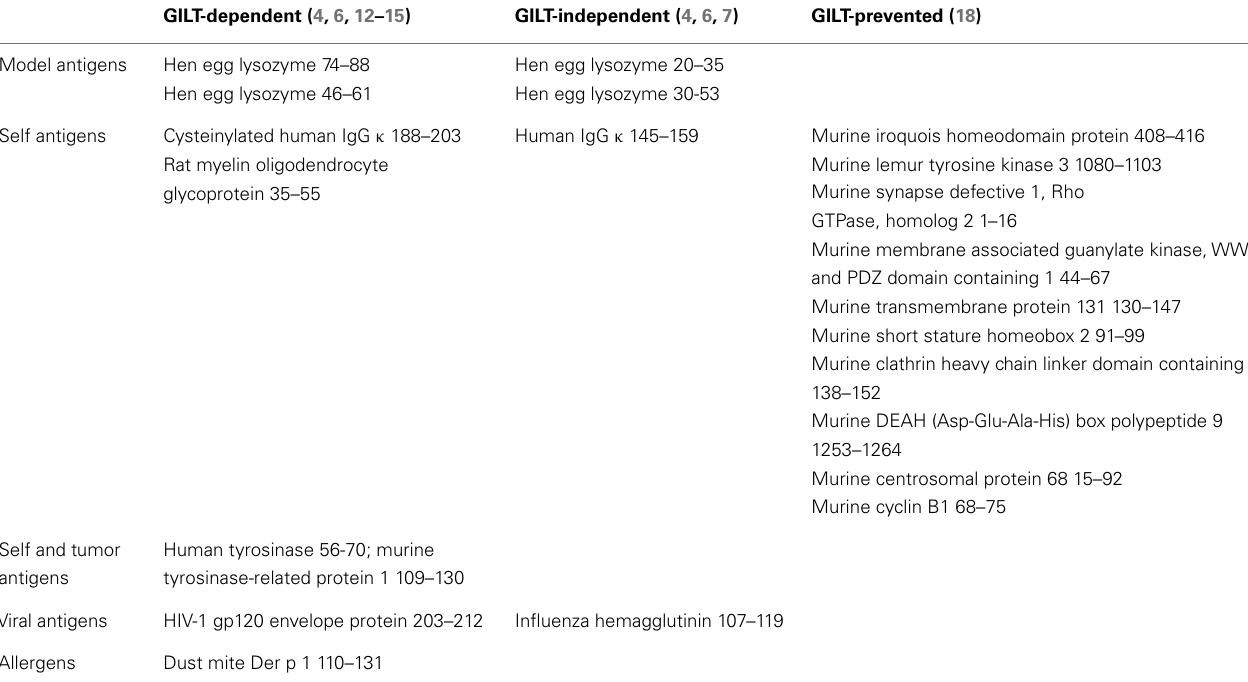
Table 1 | Examples of GILT-dependent, GILT-independent, and GILT-prevented